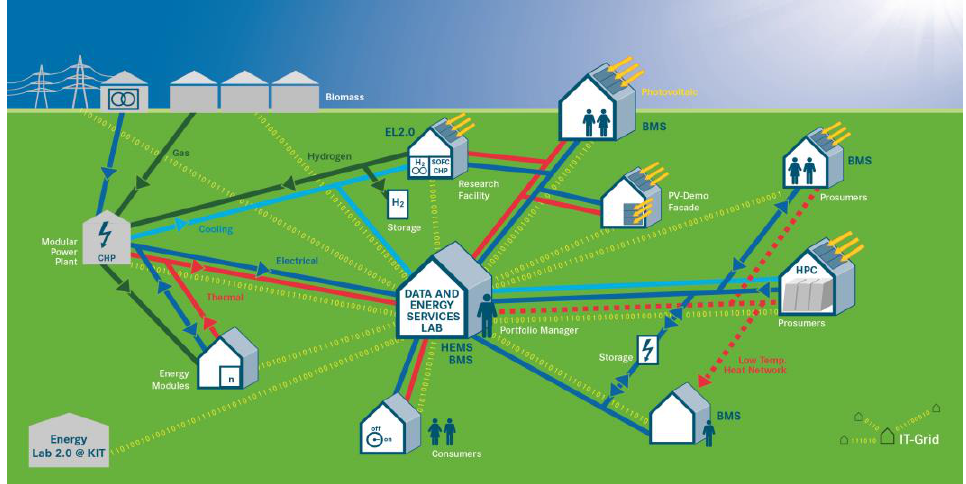
Figure 16. Living Lab Energy Campus: living lab and research platform.